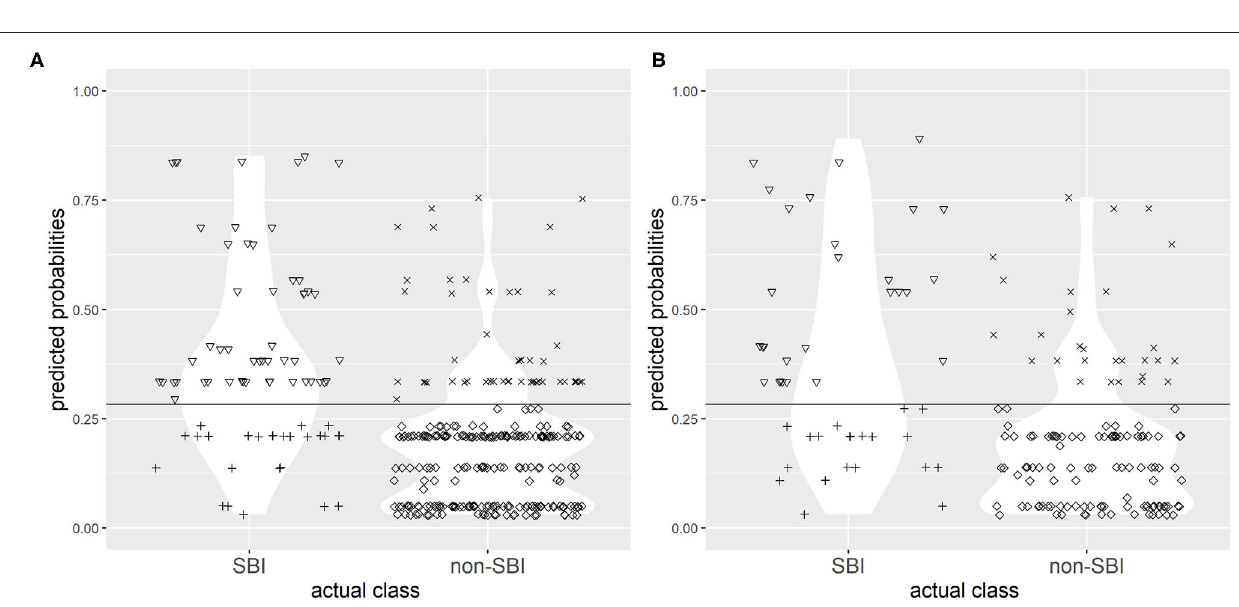
FIGURE 3 | Confusion matrix for discrimination between subjects with SBI and without SBI by clinical prediction model 1 (CPM 1) in research (A) and validation (B) populations with the chosen cut-off value of 0.219. Symbols: ▽ true positives; + false negatives; x false positives; ♦ true negatives. The horizontal line represents the cut-off